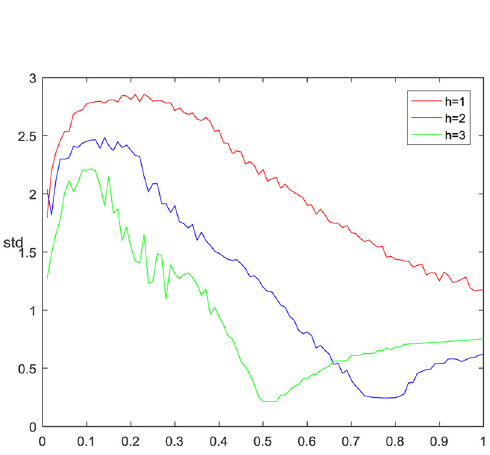
Figure 8. Price gradient h = 3